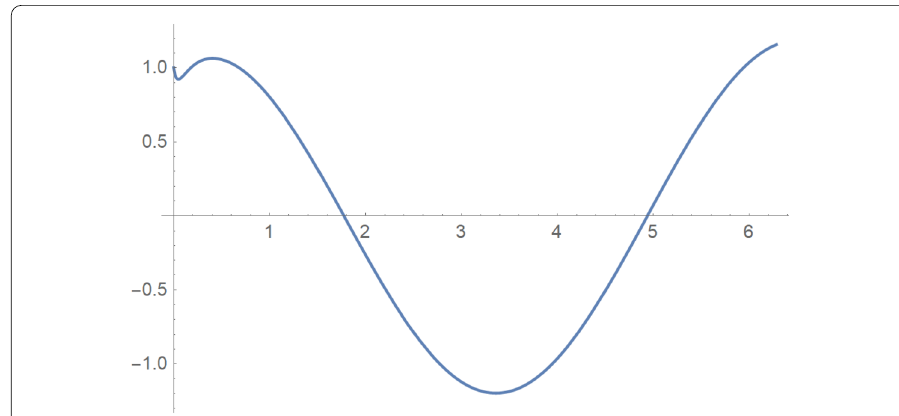
Figure 1 Solution of the problem for α = 0.1